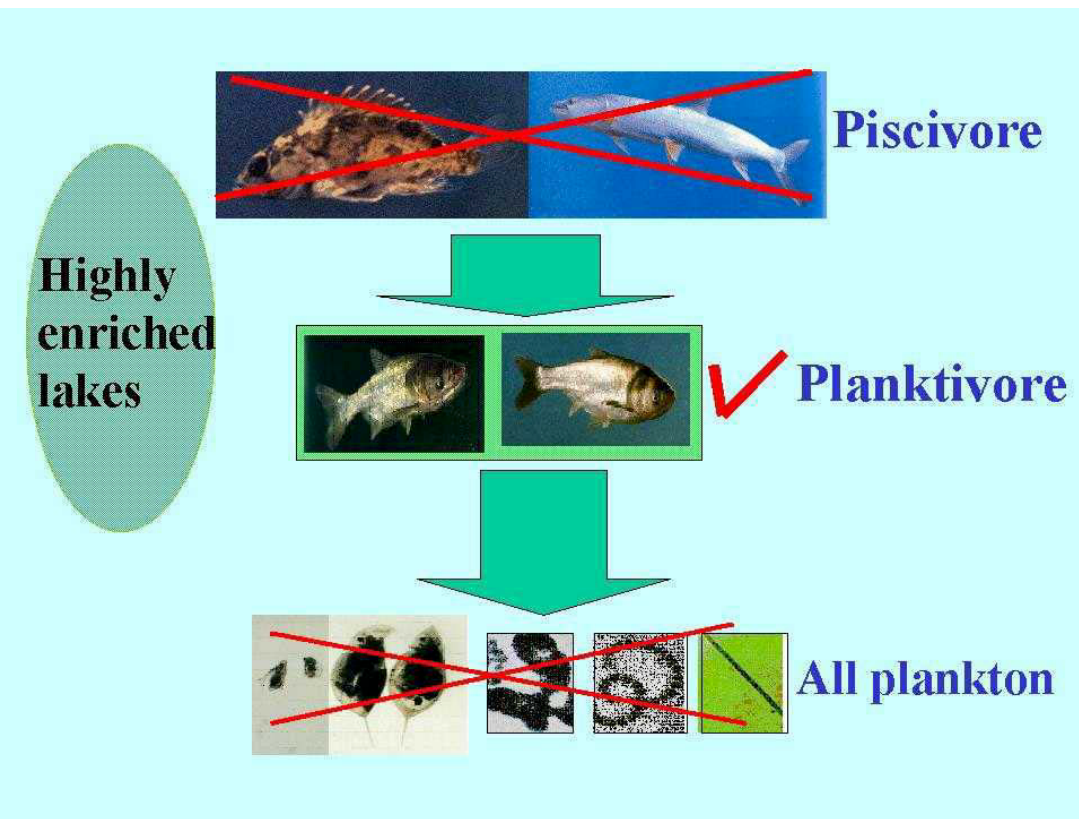
FIGURE 14. Conceptual diagram of the new biomanipulation by using filter-feeding silver and bighead carp to counteract cyanobacteria blooms.